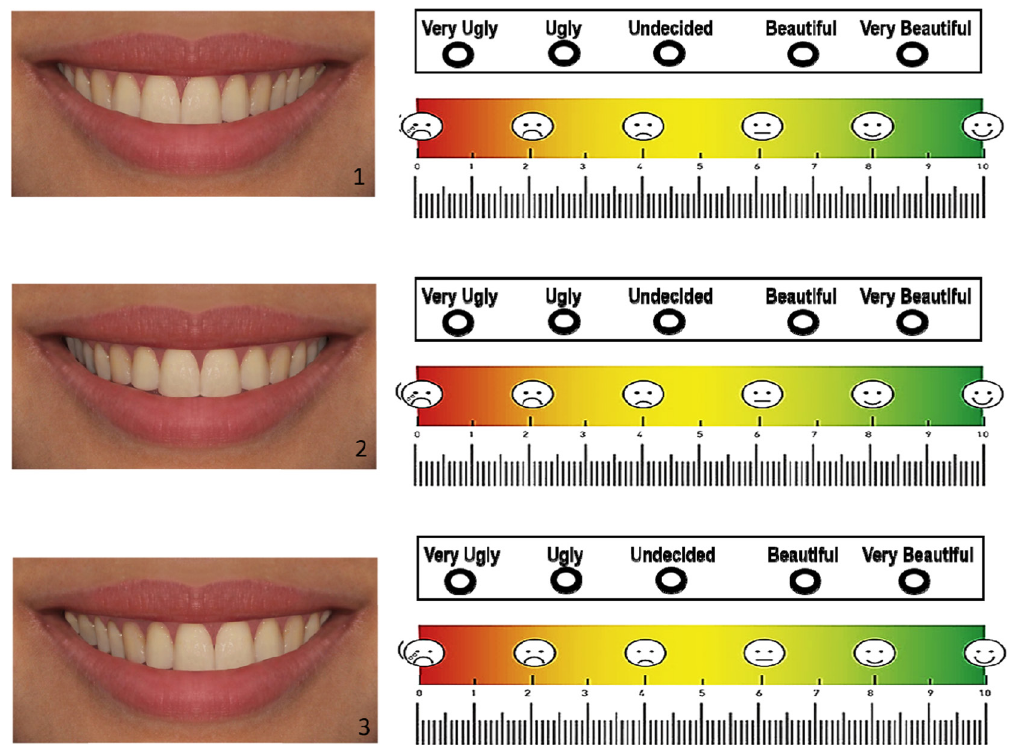
Figure 3. An example of the survey